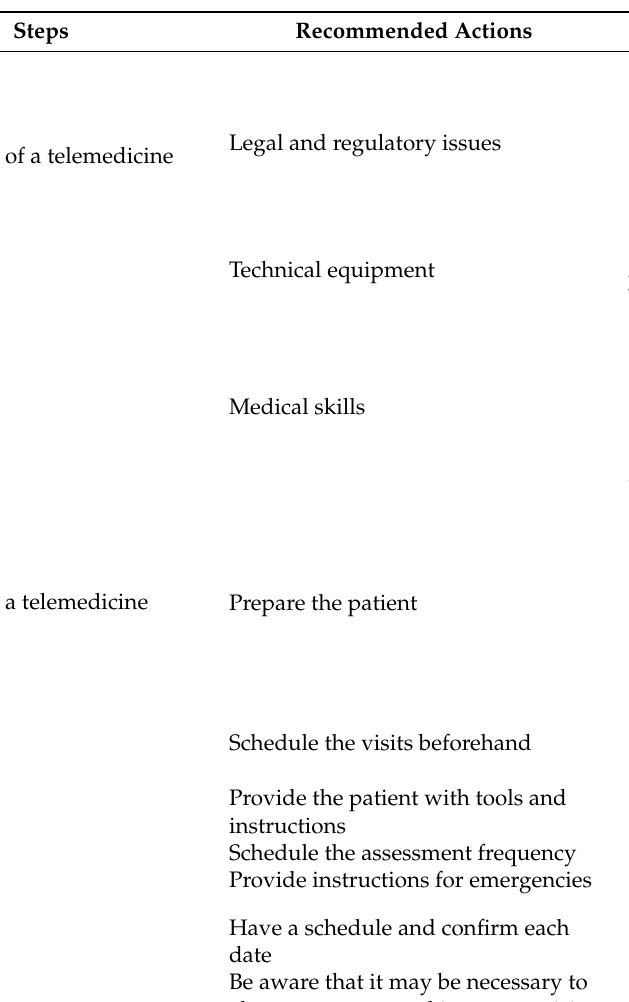
Table 1. Some recommended actions for the management of a telemedicine